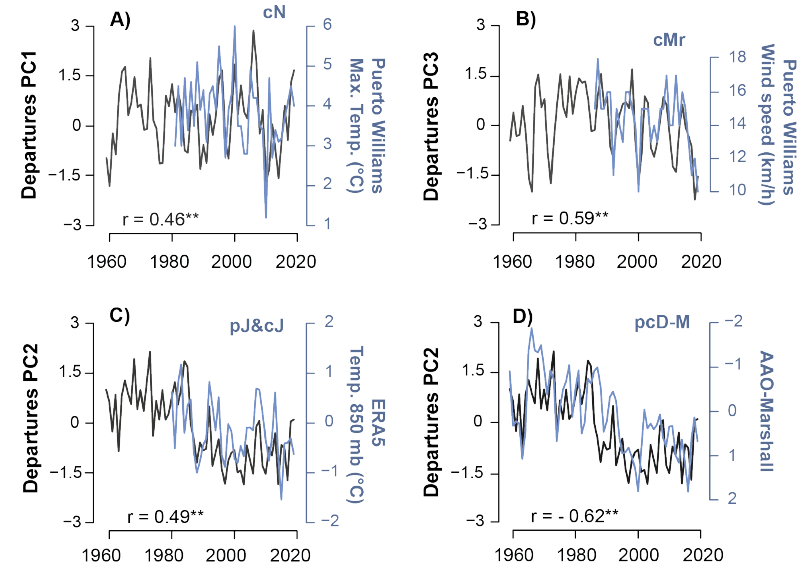
Figure 8. The most significant correlation results for the three PCs departures from SSA with different climate variables (weather stations, ERA5, and AAO index). p -value, **: significant ( p < 0.01). The best months and combination of months for the climate-tree growth correlations shown here are: ( A ) cN = current November, ( B ) cMr = current March, ( C ) pJ&cJ = previous and current January, and ( D ) pcD-M = previous and current December to